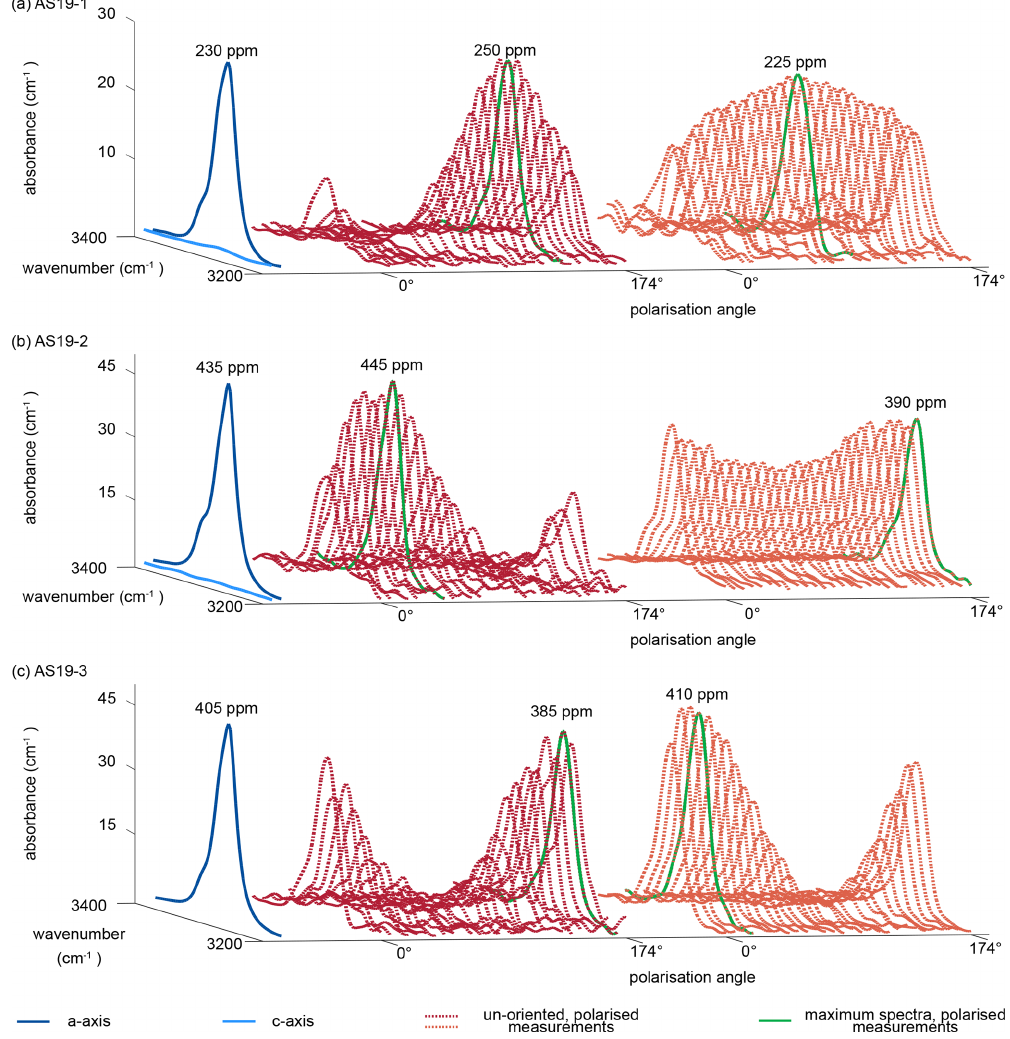
Figure 5. Polarised FTIR spectra of oriented vs. unoriented rutile grains. Spectra are normalised to 1cm. Blue spectra show absorbance measured parallel the crystallographic c and a axis, with virtually no absorbance in the c -axis spectrum. Red and orange dotted lines show polarised measurements of representative unoriented rutile grains with varying polarisation angle of 0 to 174 ◦ . The maximum spectra of the unoriented grains are indicated as bright green line and represent the a -axis spectrum. Calculated H 2 O contents for the a -axis spectrum and the maximum spectrum of the unoriented grain are